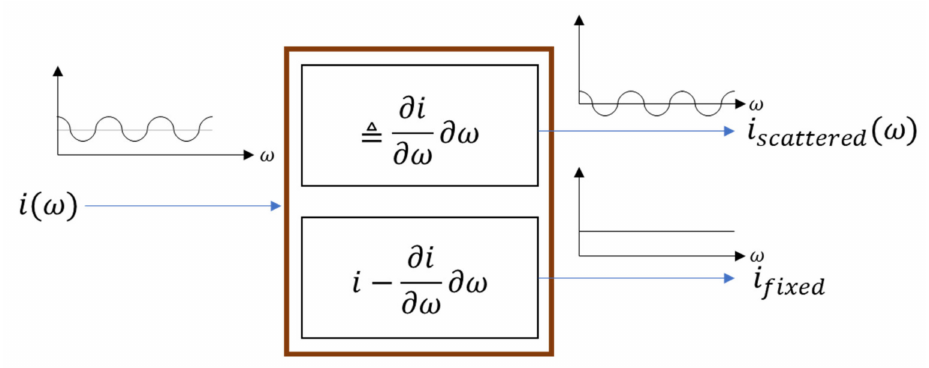
Figure 3. Scattered current as the “spectral AC” component, while the other component is the “spectral DC”